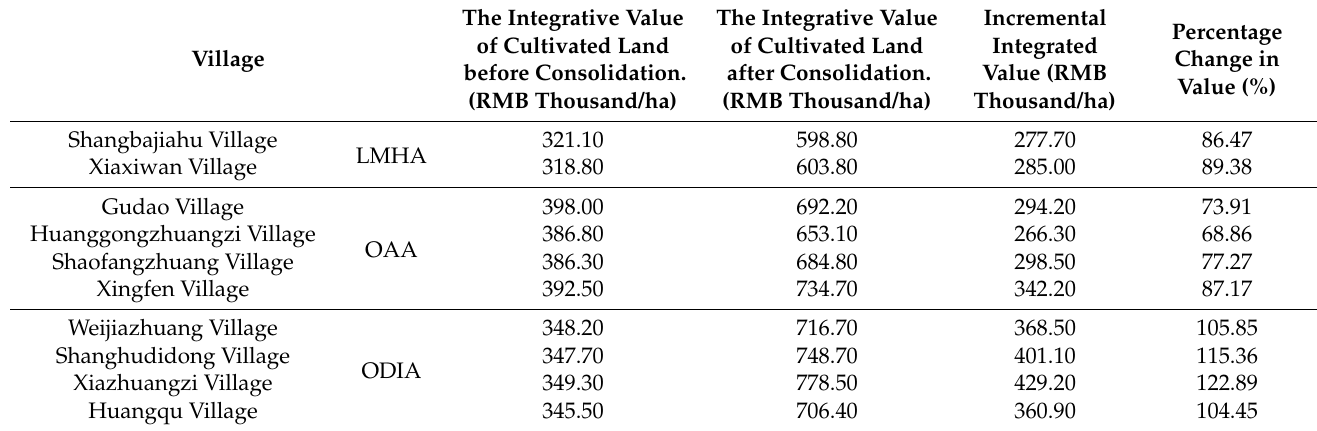
Incremental Percentage Integrated Change Value (RMB Thousand/ha)